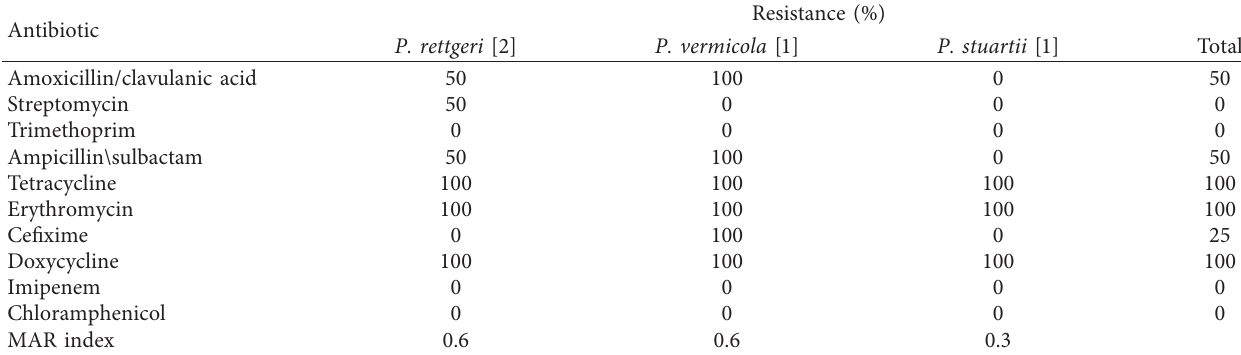
Table 1: Antimicrobial susceptibility results of Providencia spp. isolated from